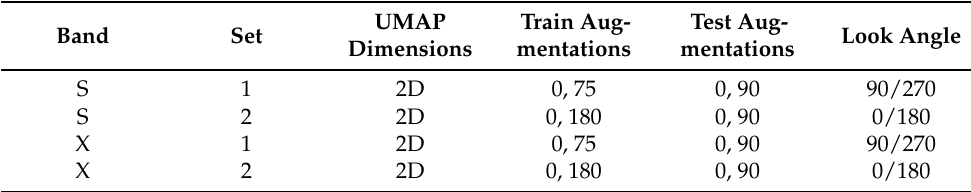
Table 6. Training augmentation sets chosen using different look angles (0 ◦ and 75 ◦ for Set 1, and 0 ◦ and 180 ◦ for Set 2) for the S- and X-band studies. Training augmentations are selected based on the smallest Mahalanobis distance between the 90 ◦ rotated images and every other augmentation set.